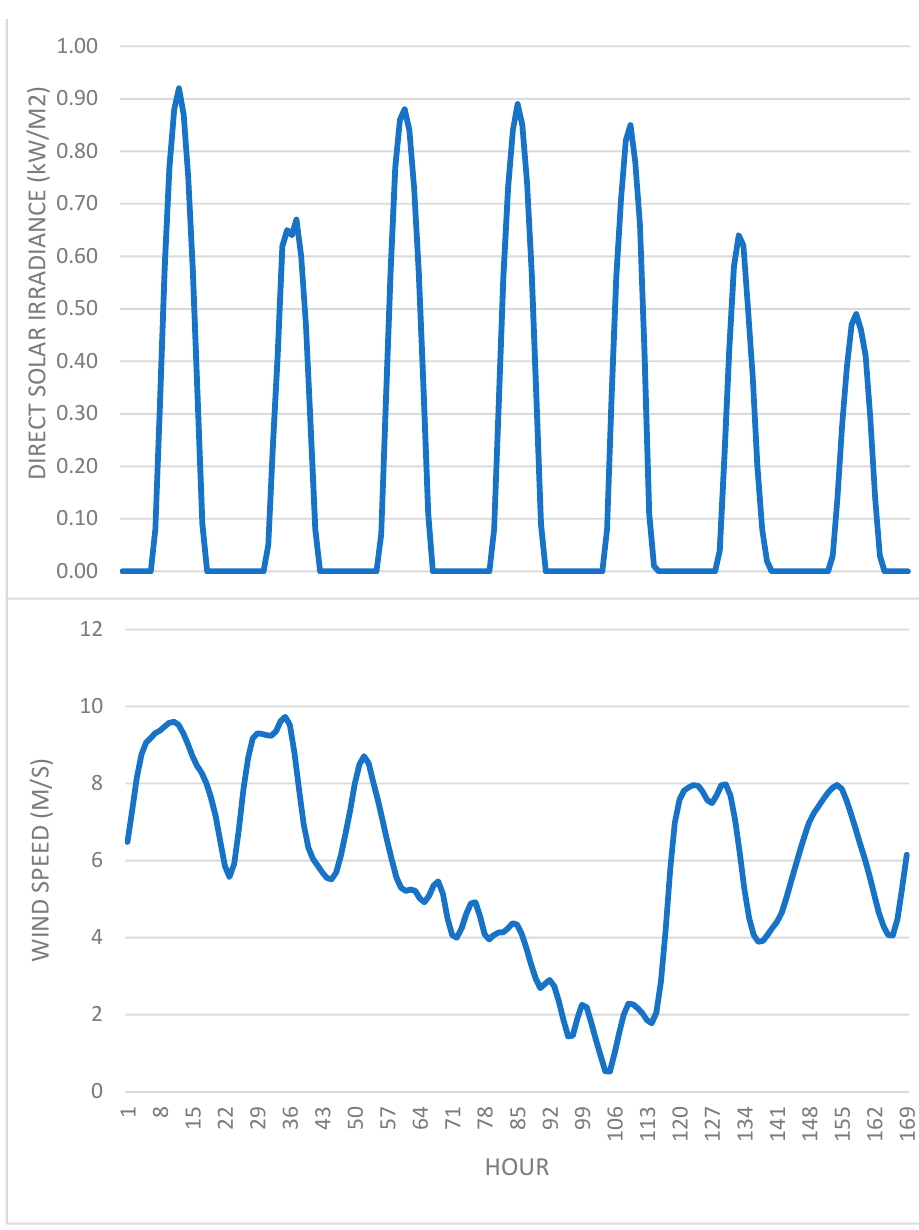
Figure 5. Example of hourly direct solar irradiance (kW/m 2 ) and wind speed measurement (m/s) in 50 m hub height for 1–7 January 2019 in Isla de la Juventud. Data: [44,45]. Figure 5 shows the hourly direct solar irradiance and wind speeds for the first week of January. It can be seen that the highest solar irradiance takes place during noon time and naturally decreases towards the night until gradually increasing from morning hours. The wind fluctuation does not follow any specific trends but varies from day to day regardless of the time of the